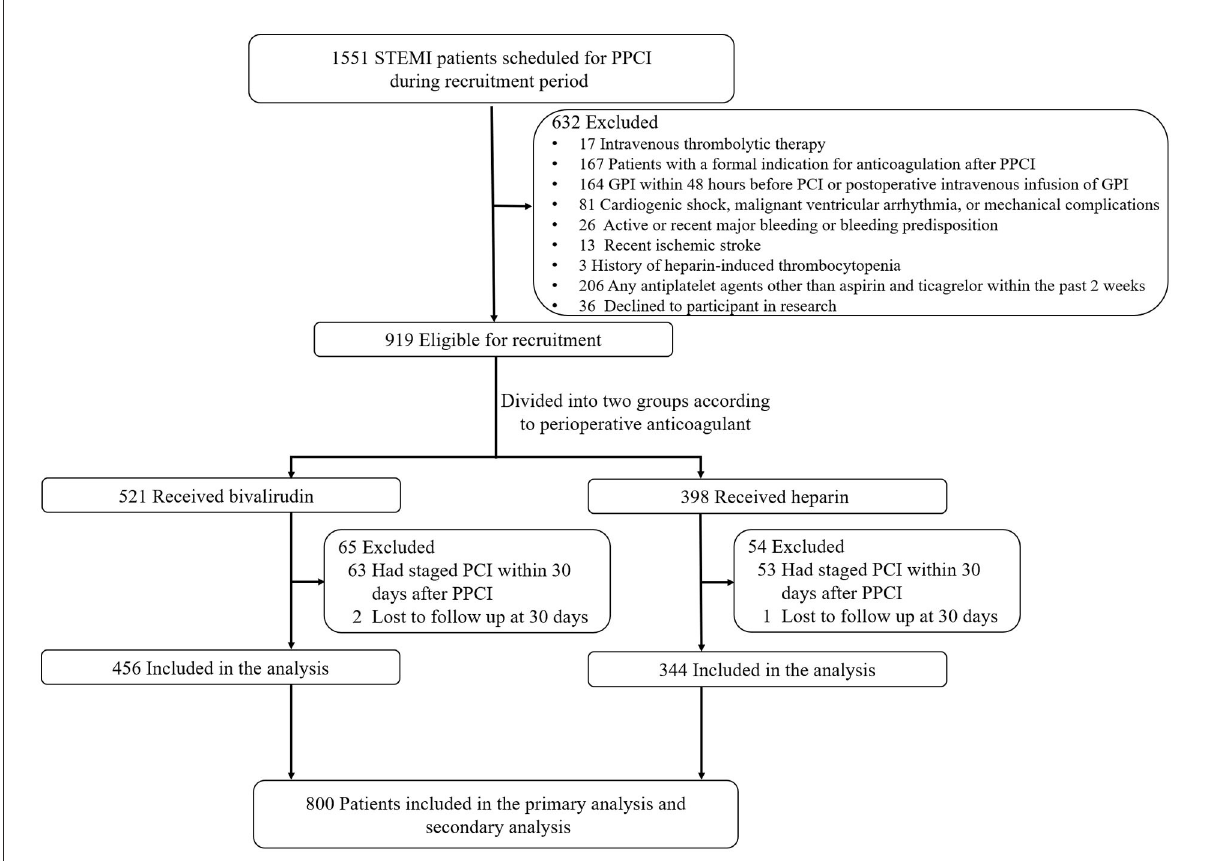
FIGURE1 Flow diagram of the study. PPCI, primary percutaneous coronary intervention; GPI, glycoprotein IIb/IIIa